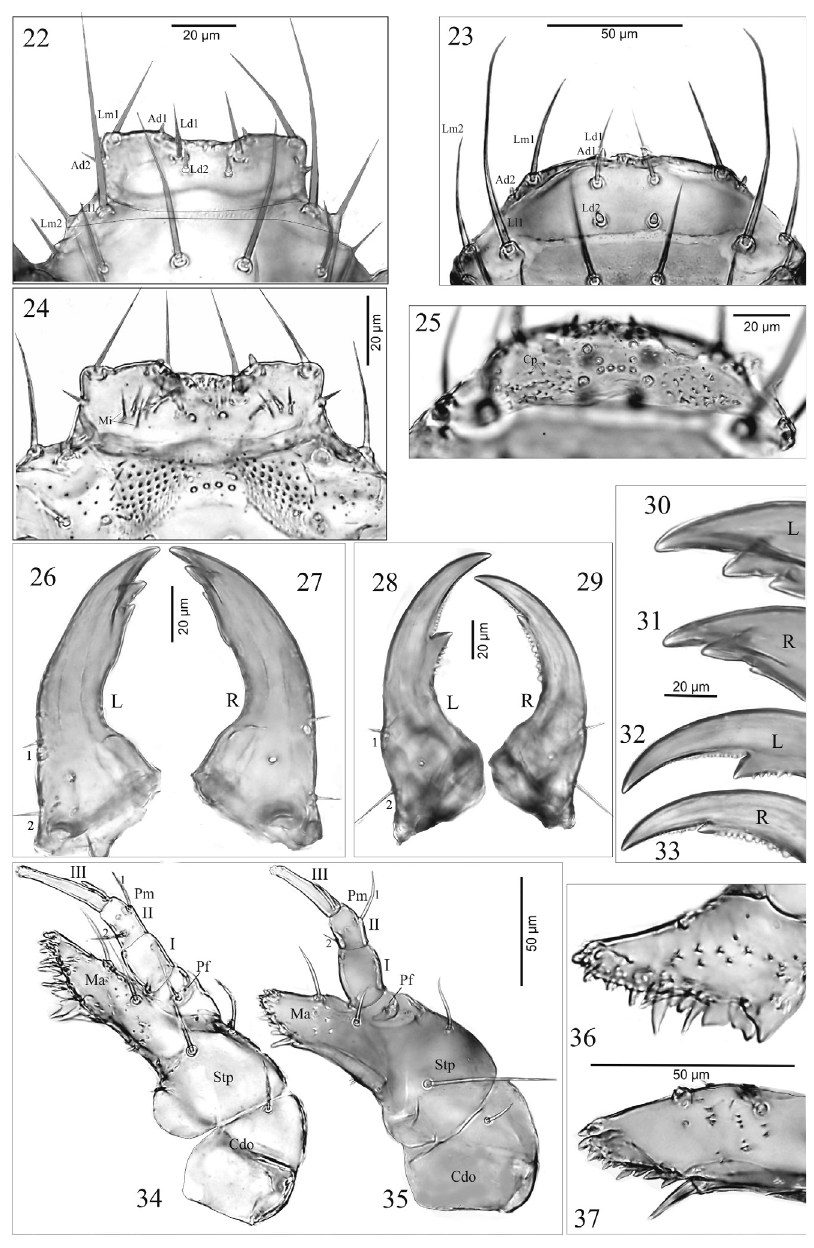
mature larva 22, 23 labrum 24, 25 epipharynx 26–29 left (L) and right (R) mandible, in dorsal aspect; 30–33 anterior region of left (L) and right (R) mandible, in dorsal aspect 34, 35 right maxilla in ventral aspect 36, 37 right mala in ventral aspect. Abbreviations: I-III, articles of maxillary palp; 1, 2, mandibular setae; Ad, additional setae; Cp, cuticular processes; Cdo, cardo; La, labral anterior setae; Ld, labral dorsal setae; Lm, labral marginal setae; Mi, microtrichia; Ma, mala; Pf, palpifer; Pm, maxillary palp; Stp,